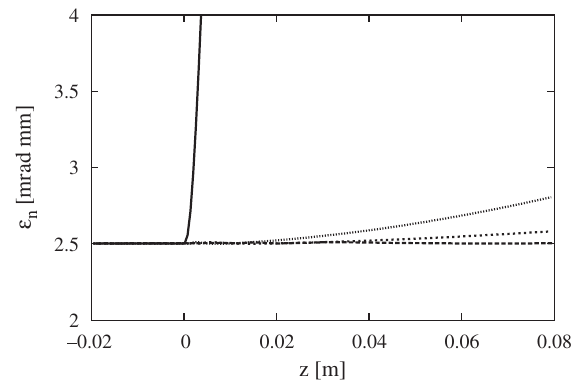
FIG. 4. Development of the transverse beam size in a matching section with g ¼ 500 m − 1 (solid line). Broken lines indicate the further development in a drift when the matching section ends at j α j ¼ 0 . 5 ; 1 . 0 and j α j ¼ 2 . 0 . The last line overlaps already e e completely with the solid